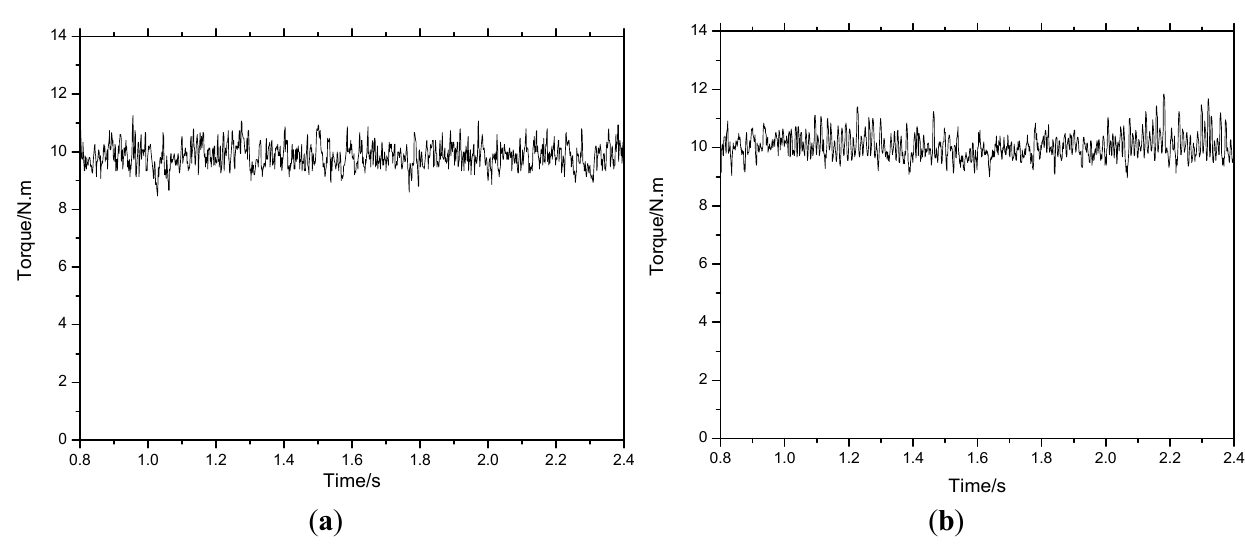
Figure 8. Time response of the output torque in steady state when using different controller = 10 N. m and n = 200 rpm): ( a ) conventional PI controller; and ( b ) proposed ( T L sliding mode